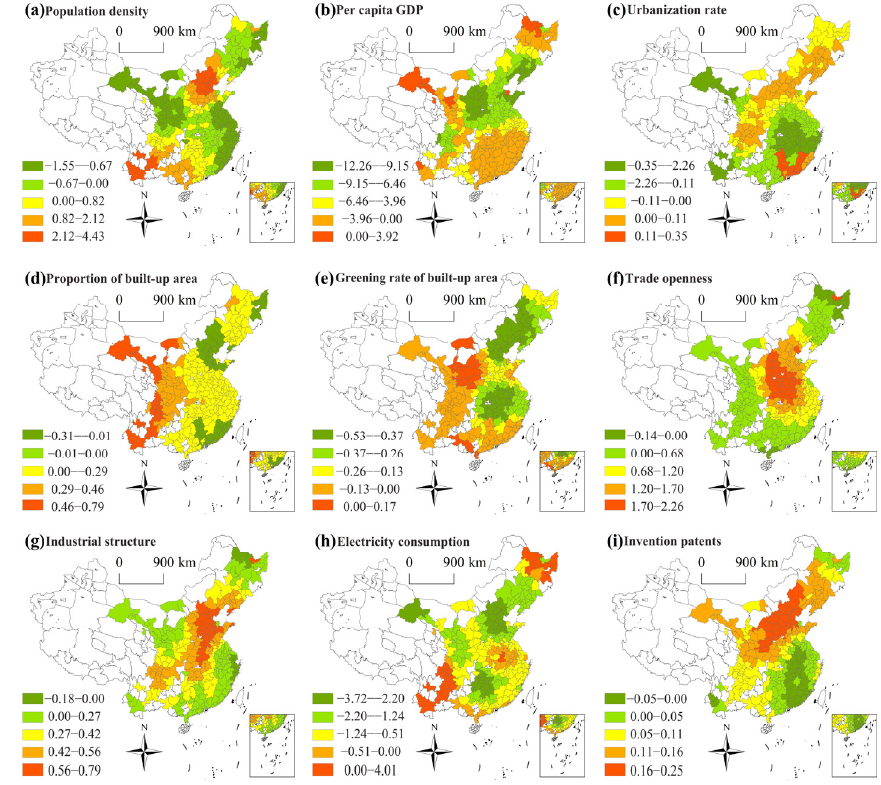
Figure 6. Spatial distribution of socioeconomic factors coefficients.